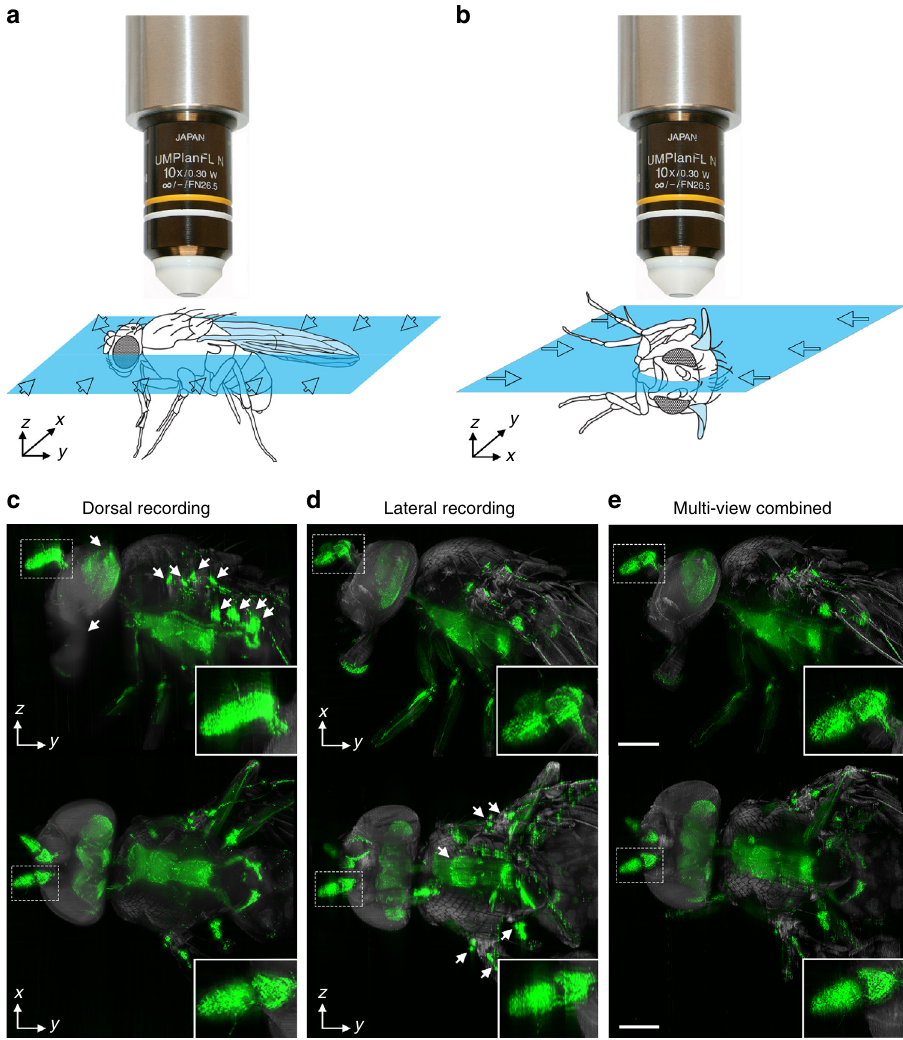
Fig. 6 Multi-view combining of ultramicroscope recordings from orthogonal directions. a , b Illustration of the two sided light-sheet illumination through the specimen. Illumination direction is indicated by blue arrows c , d Lateral (upper panel) and dorsal (lower panel) view of ultramicroscope recordings from FlyClear processed, GFP-expressing samples. Unsharp areas are indicated by arrowheads. a Scheme of the lateral illumination plan and c corresponding recording of D. melanogaster . Insets show bigger magni fi cation of antenna. b Scheme of the 90° tilted illumination plane and d corresponding recording of the specimen. Insets show higher magni fi cation of the antenna. e Multi-view combined reconstructions of the stacks in c and d . Insets show higher magni fi cation of the antenna. GFP signal is represented in green and auto fl uorescence is represented in grey. All images were acquired with 2x post- magni fi cation in combination with a 4x Objective (Olympus, XLFluor4x/340, 0.28NA, WD = 29.5 mm) with custom-made correction of optics for a refractive index of 1.45 (WD after correction 10 mm). Scale bars represent 200 µ